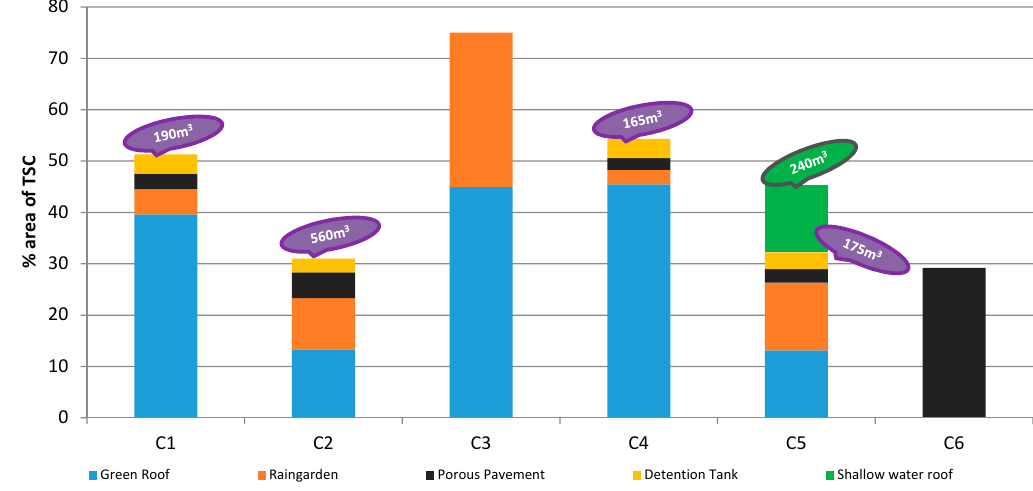
Figure 12. ABC Waters design features and detention facilities implemented in TSC.